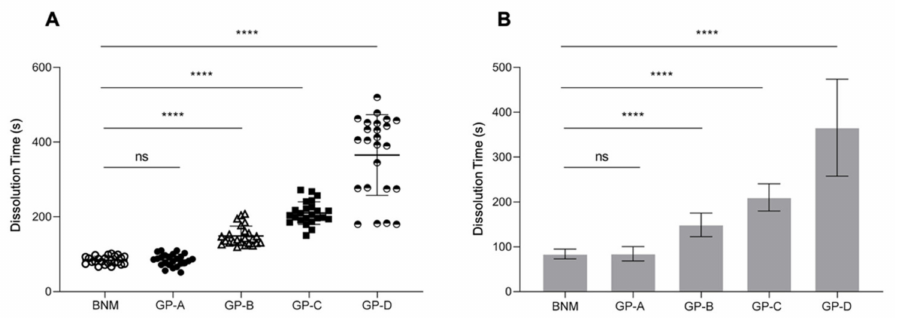
Figure 3. Comparison of dissolution time under simulated clinical conditions between BNM and six GPs ( A ): each dot represents one sample, 3 batches of samples were tested for each product, 8 samples tested for each batch; ( B ): data presented as mean ± standard deviation, ns: not significant (**** p <